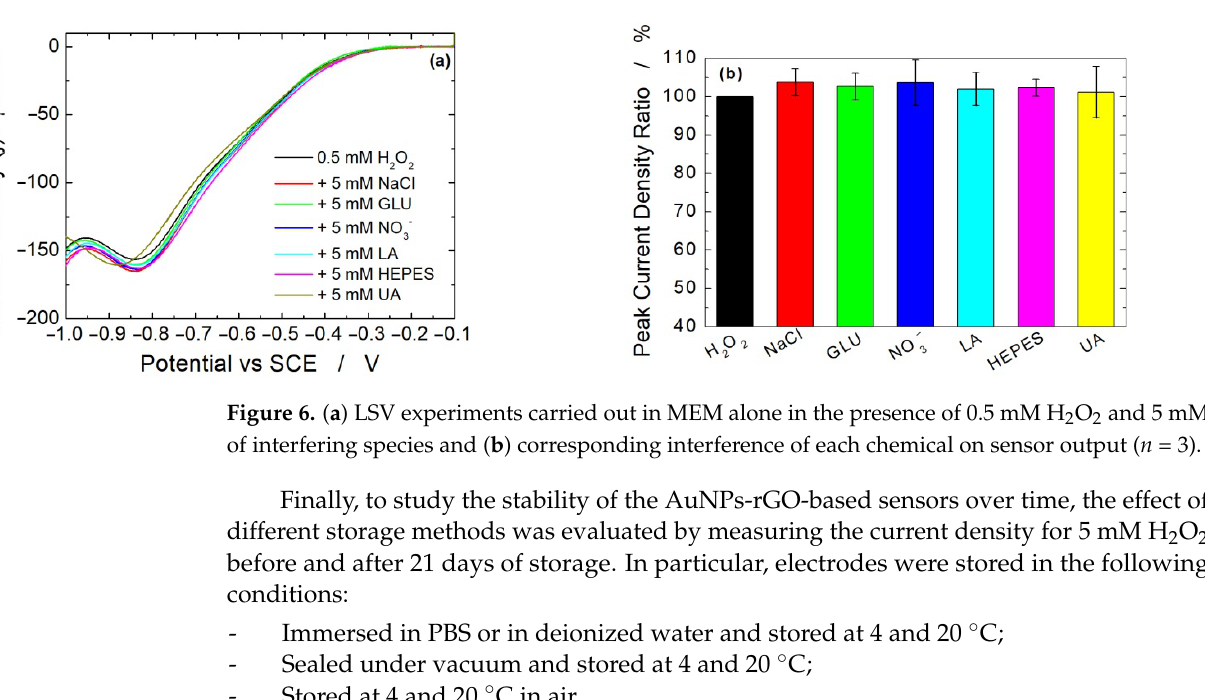
Figure 5. ( a ) LSV experiments at increasing H 2 O 2 concentration and ( b ) corresponding calibration line. The tests were performed in pure MEM and at 37 °C (N = 3).